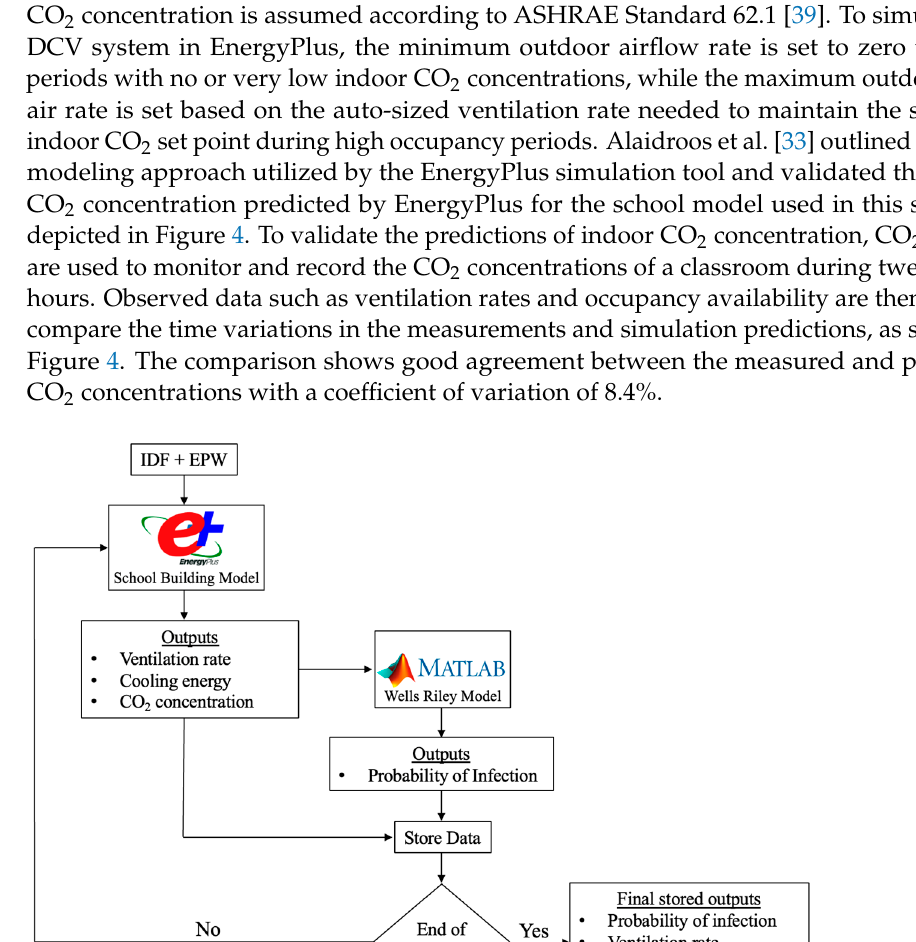
Figure 4. Validation of the time variation in the indoor CO 2 concentration for the analyzed school.